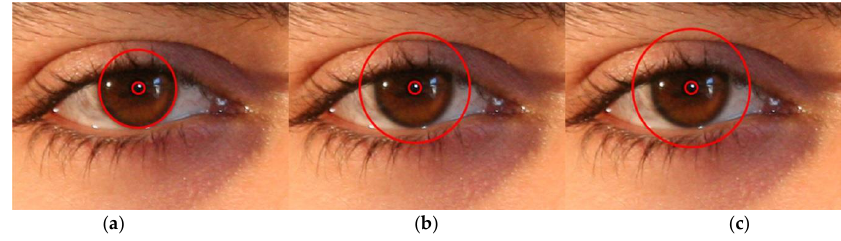
Figure 4. Examples of the iris and periocular regions. ( a ) Iris region; ( b ) periocular region based on w 1 × IRrad ; ( c ) periocular region based on w 2 × IRrad .